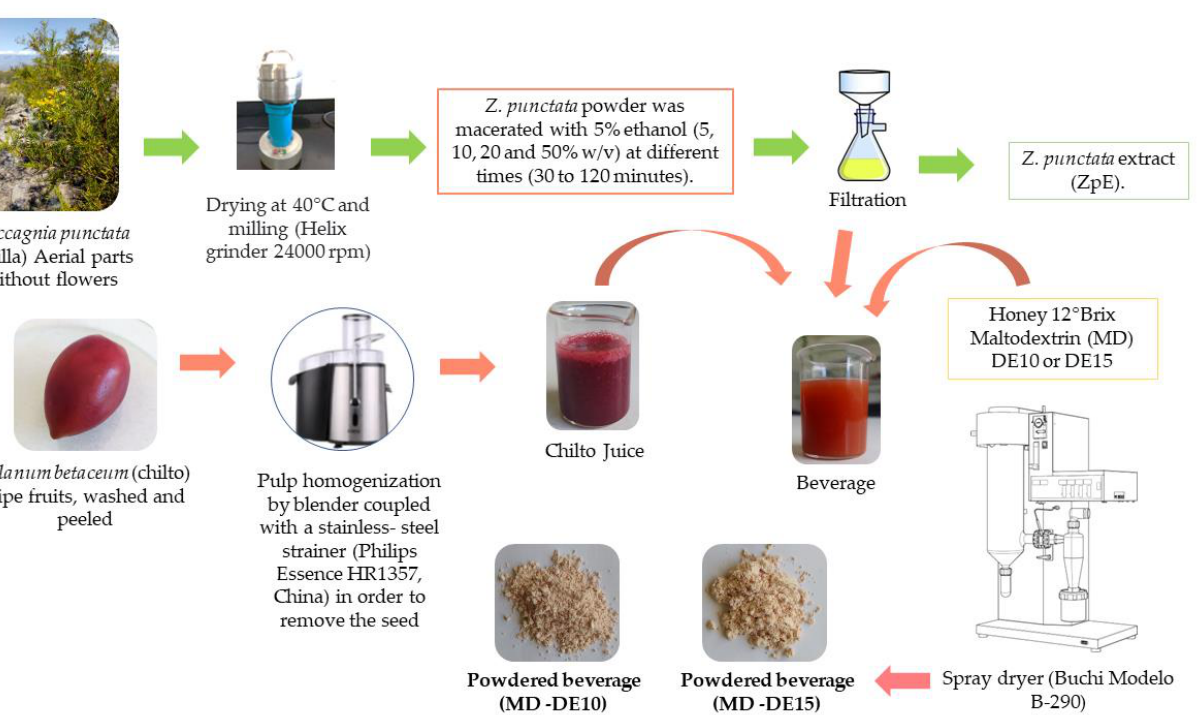
Figure 2. Diagram describing obtention procedure of both Zuccagnia punctata extract and chilto juice beverages.